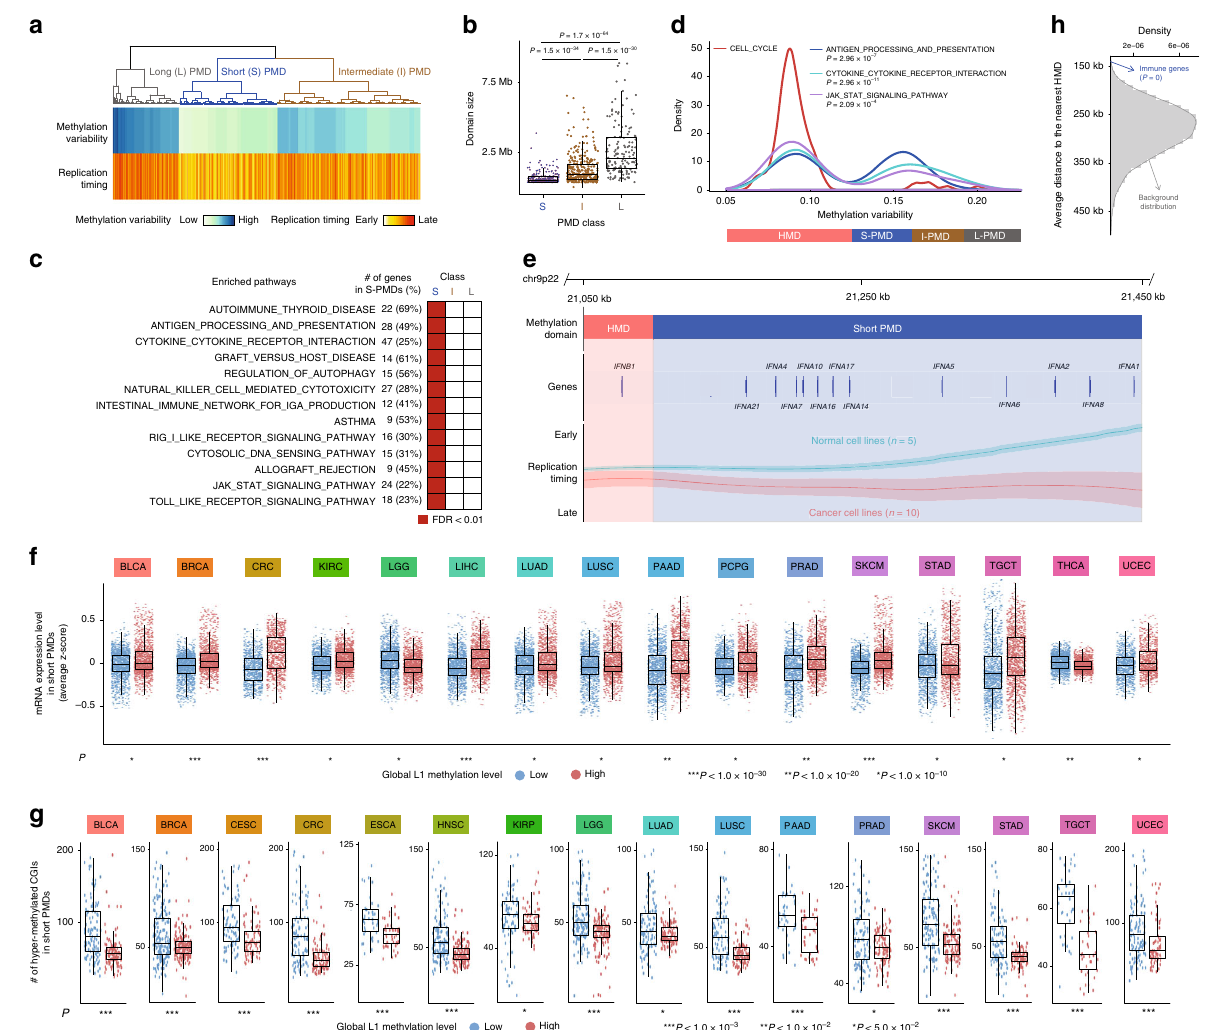
Fig. 4 Characterization of genes in partially methylated domains. a Identi fi cation of PMD subclasses through hierarchical clustering on methylation variability and replication timing. b Comparison of PMD size between the identi fi ed PMD subclasses. c Enrichment of genes in immune-related pathways in the short PMDs. d Distribution of domain methylation variability for genes in cell cycle and immune pathways. The two-sample Kolmogorov-Smirnov test was used to assess deviation from the distribution of the cell cycle genes. e IFN- α genes in a short PMD with late replication timing. The mean and standard error of the weighted average signals of replication timing in normal cells and cancer cells are shown. f Comparison of the mRNA expression level of genes in the short PMDs between tumour samples with low and high global methylation. Tumour types for which the paired t-test P < 1.0 × 10 − 10 are shown. g Comparison of the number of hyper-methylated promoter CGIs in the short PMDs between tumour samples with low and high global methylation. Tumour types with P < 5.0 × 10 − 2 (two-sided Mann – Whitney U test) are shown. h Concentration of immune genes near PMD boundaries. The average distance of the immune-related genes (from b) to the nearest HMDs is marked by an arrow. The statistical signi fi cance of the observed average distance was assessed based on a null distribution generated by using random PMD Fig. 5g) resulted in HR = 0.57 (log rank test, P = 4.0 × 10 − 2 ) and our pan-cancer molecular data analyses, the global low methyla- tion samples showed high mutation burden and aneuploidy as HR = 0.52 (log rank test, P = 5.0 × 10 − 2 ), respectively. Whereas the P values decreased as sample size grew, the effect size (HR) well as CGI hypermethylation in the short PMDs (Fig. 5d). remained a similar level. Transcriptome data of the SMC cohort and TCGA cohort showed that genes involved in the MHC and cytokine-cytokine receptor mutation load on the clinical response. For the combined lung interaction were signi fi cantly enriched for repression in globally cancer cohort, methylome and matched exome data were demethylated tumours of both cohorts (Supplementary Fig. 6 and available for 82 samples in total (Fig. 5a). In contrast to the Supplementary Data 3). global L1 methylation level (log rank test, HR = 0.46 and P = High mutation load is associated with the clinical bene fi t of 7.0 × 10 − 3 ), mutation burden failed to show signi fi cant explana- checkpoint blockade 2 – 5 . However, when we strati fi ed patient samples according to the L1 methylation levels, the global low tory power (log rank test, HR = 0.77 and P = 0.3) (left and methylation group showed poor prognosis despite high mutation middle of Fig. 5h). Multiple regression with survival or clinical load. In the combined lung cancer cohort ( n = 141), the hazard bene fi t as the response variable demonstrated signi fi cant effects ratio (HR) was 0.56 (log rank test, P = 7.0 × 10 − 3 ) (Fig. 5e). The by the global L1 methylation level but not mutation burden at P = 0.05 (right of Fig. 5h). We repeated the univariate IDIBELL cohort (n = 81) (Fig. 5f) and SMC cohort (left of